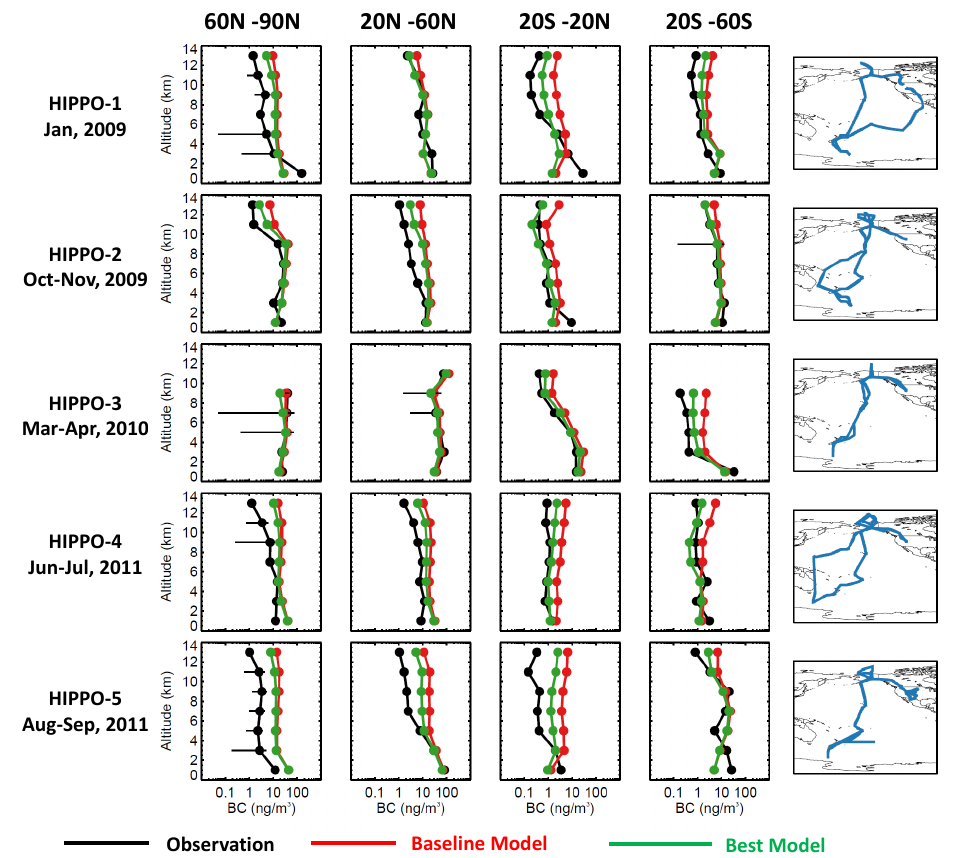
Figure 2. The mean vertical profile of BC mass concentrations (shown in 1km bins) from the five HIPPO campaigns in 2009-2011, shown by region and different campaign (year and season). Observations (black) are compared with the “baseline” (red) and the “best” (green) GC-RT simulation. Error bars show the standard deviation of measurements averaged in each vertical bin. The last column shows the flight route for each